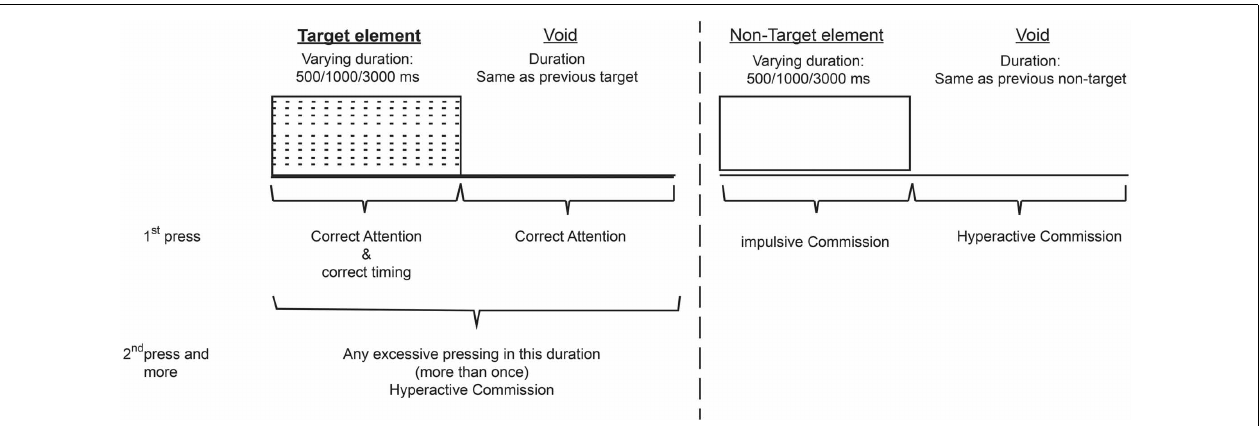
the full duration regardless the response. Distracting stimuli were not synchronized with target/non-targel’s onset and could be generated during target/non-target stimulus or during the void